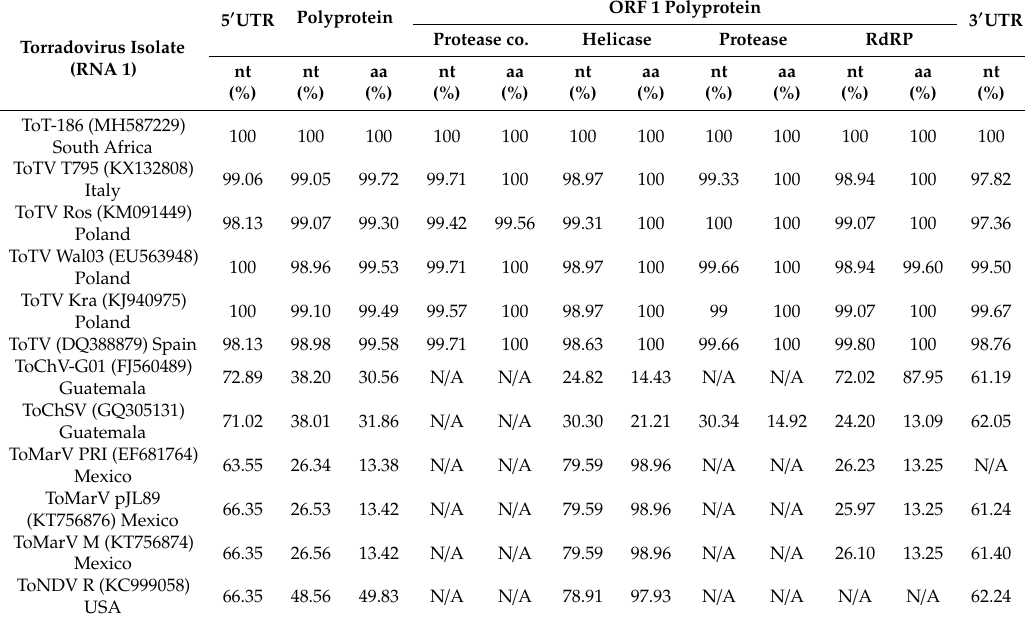
Figure 2. Bipartite genome organization of torradoviruses. RNA-1 encodes a large polyprotein (ORF-1) that contains a protease cofactor (PRO-co), helicase (HEL), 3C-like protease (PRO), and an RNA-dependent RNA polymerase (RdRp) which are involved in proteolytic cleavage and replication. RNA-2 encodes a hypothetical protein that partially overlaps ORF 2. Motifs associated with a movement protein (MP) and three coat proteins are present in ORF-2. Table 1. A comparison of the nucleotide and amino acid similarities of coding and non-coding regions on the RNA-1 fragment of Tomato torrado virus (ToTV) from South Africa (ToT-186) with all other fully sequenced tomato-infecting torradovirus species identified throughout the